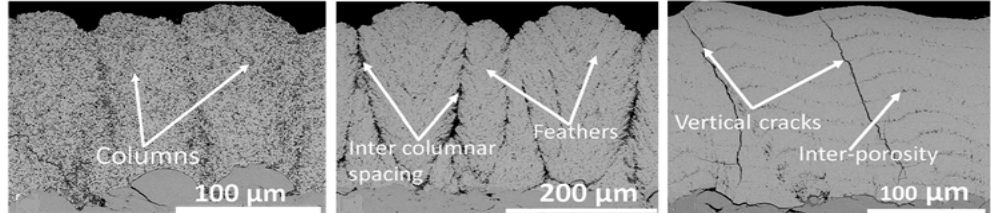
Figure 1. Di ff erent coating microstructures produced by suspension plasma spray (SPS). Adapted from from [5].